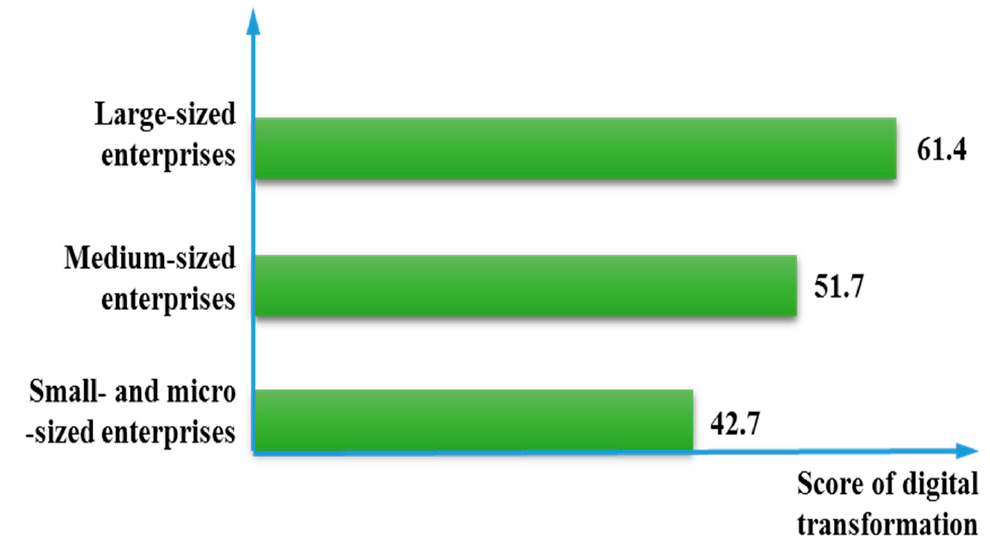
Figure 8. Digital transformation level of enterprises of different sizes.